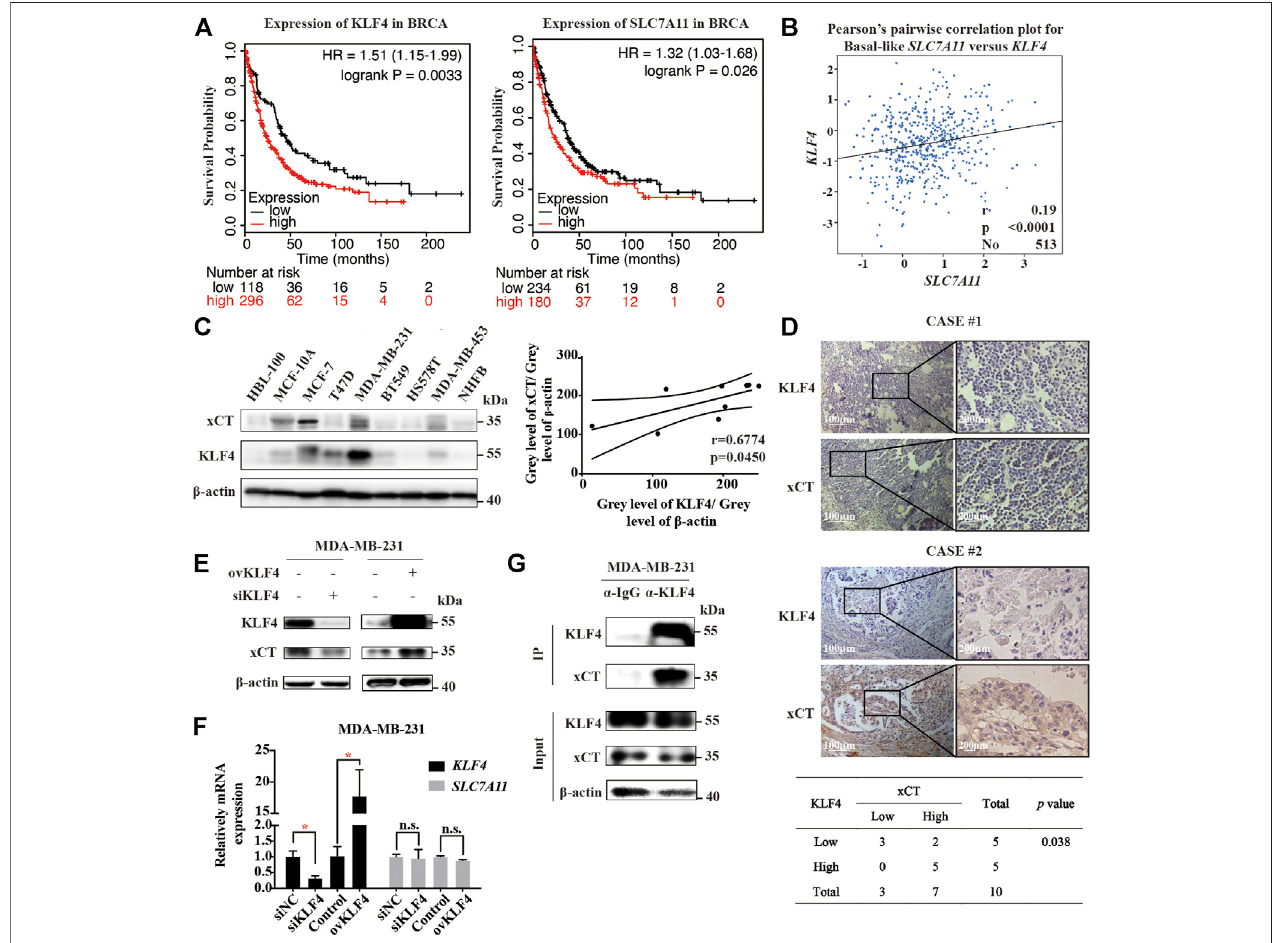
FIGURE 4 | The expressions of KLF4 and xCT are positively correlated in breast cancer. (A) . Online Kaplan-Meier Plotter analysis (http://kmplot.com/analysis) of breastcancerpatientoutcomes.Differencesinpostprogressionsurvival(PPS)werecomparedingroupsstrati fi edbyKLF4orSLC7A11status. (B) .AnalysisoftheGEO database shows that the expression levels of KLF4 and SLC7A11 in basal-like breast cancer cells are positively correlated. (C) . Western blot analysis of KLF4 and xCT expression in different breast cancer cell lines. The p value was calculated using Pearson correlation analysis. (D) . Immunohistochemical staining of KLF4 and xCT in clinical specimens of breast cancer patients. The correlation between KLF4 and xCT was assayed ( n (cid:2) 10, p value was calculated using Pearson correlation analysis). (E) .WesternblotanalysisofxCTexpressionafter knockingdownoroverexpressingKLF4. (F) .qRT-PCRanalysisofrelativexCTmRNAexpression afterknockingdown or overexpressing KLF4. (G) . The protein interaction between KLF4 and xCT was detected by immunoprecipitation. * p < 0.05; ** p < 0.01; *** p < 0.001; n. s., not signi fi cant ( p >